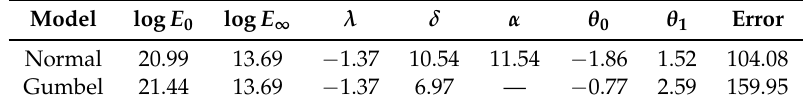
Table 1. Estimates of dimensionless parameters and the absolute errors for the two proposed models in fitting short-term curves for PVB data.